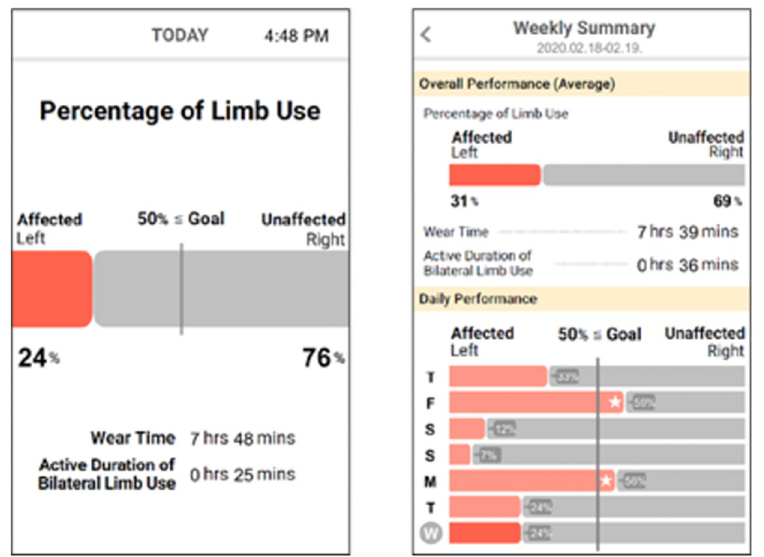
Fig 2. One of the study probes—a basic bar chart—that we designed and presented to P1 based on her own data: daily performance (left) and weekly performance trajectory (right). The patients’ response to the chart design is beyond the scope of this study, and hence the rest charts are omitted in this